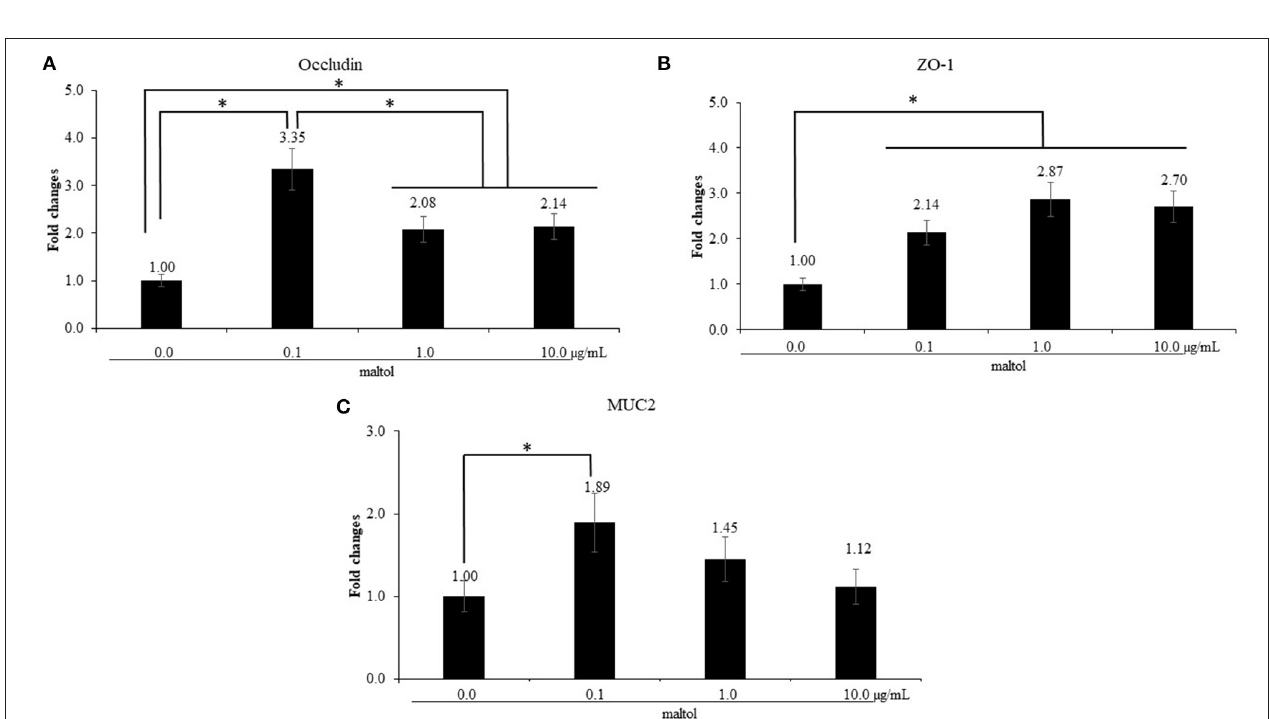
FIGURE 3 | Alteration of tight junction proteins and mucin in chicken epithelial cells (IEC) by maltol. Each bar represents the mean ± SEM ( n = 3). Transcript levels of the tight junction proteins were measured using quantitative RT-PCR and normalized to GAPDH transcript levels. Significant results are marked as * ( P < 0.05).